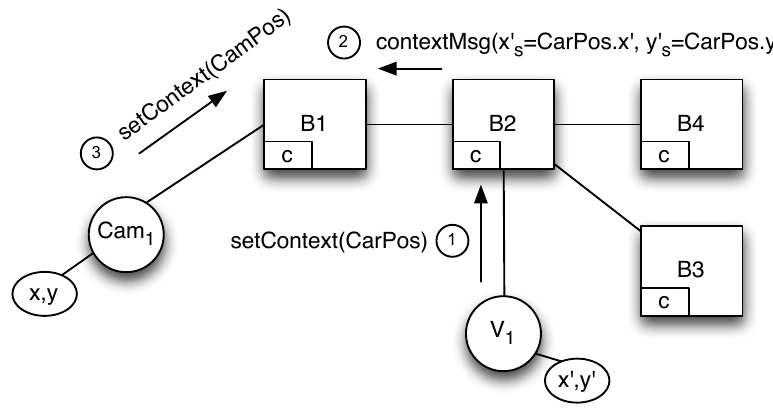
Figure 6. Context change of a